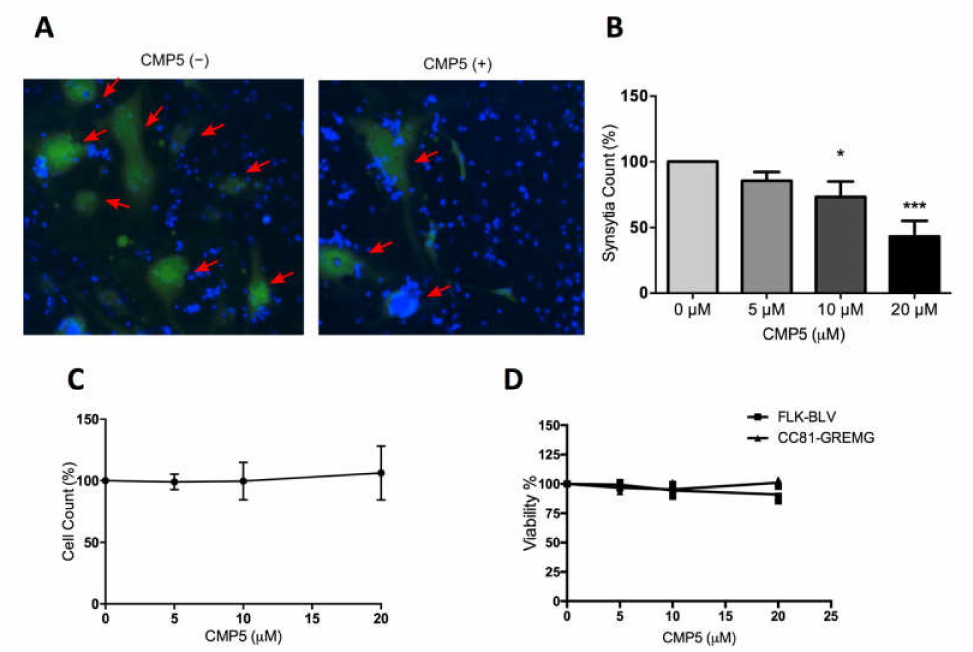
Figure 9. CMP5 e ff ect on BLV ENV-mediated syncytia formation. A BLV-producing cell line FLK-BLV was co-cultured with a reporter cell line CC81-GREMG and treated with Milli-Q water (CMP5 − ) or CMP5 at the indicated concentrations (CMP5 + ) for 48 h. ( A , B ). Fluorescent syncytia in nine fields of view in each well were automatically scanned by EVOS2 fluorescence microscopy with a 4 × objective. Fluorescent syncytia were recognized by enhanced green fluorescent protein (EGFP) expression and gated by their area and intensity. Red arrows indicate positions of fluorescent syncytia. Hoechst 33342 was used to stain the nucleus. Each picture is a representation of nine pictures acquired for each well. ( B ) Data analysis of ( A ) shows syncytia count using HCS Studio Cell Analysis software. Error bars represent the standard deviation of three independent experiments, the p value was calculated by ANOVA (0.00031), and Dunnett’s multiple comparisons test showed a significant decrease in the syncytia count at 10 µ M (* p = 0.017) and 20 µ M (*** p = 0.0002). ( C ) E ff ects of CMP5 on the total cell count taken from gating and counting of Hoechst 33342 staining using HCS Studio Cell Analysis software (Thermo Fisher Scientific). ( D ) CMP5 e ff ect on cell viability according to WST-1